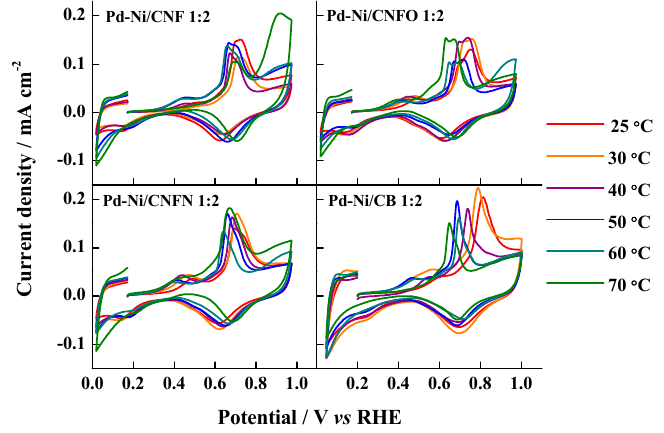
Figure 7. CO stripping voltammograms for the synthesized Pd-Ni catalysts at the temperature range (20–70 °C). Support electrolyte: 0.1 M KOH. Scan rate: 20 mV ∙ s − 1 . E ad = 0.2 V vs. reference hydrogen electrode (RHE).